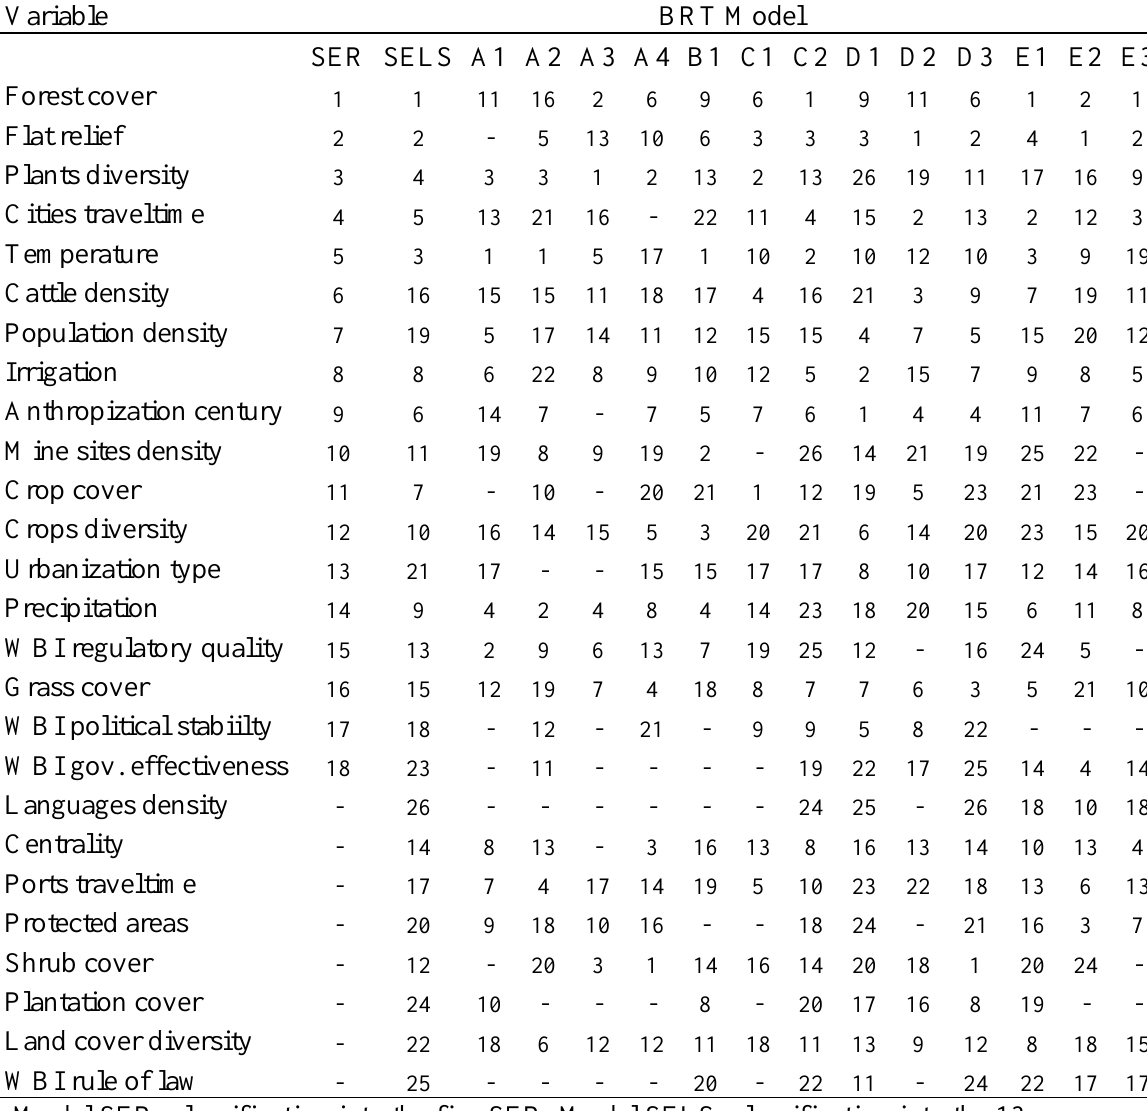
Table A3.1. Ranking of variables’ contribution to a series of general and specific classification models. The numbers represent the order of contribution of the variables (rows) to each of the different models (columns), where 1 means the most relevant and 26 the least relevant variable for that particular